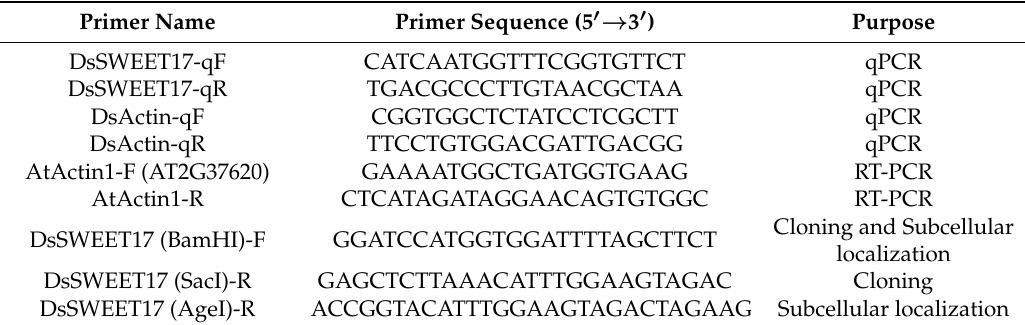
Table 1. List of primers used in this